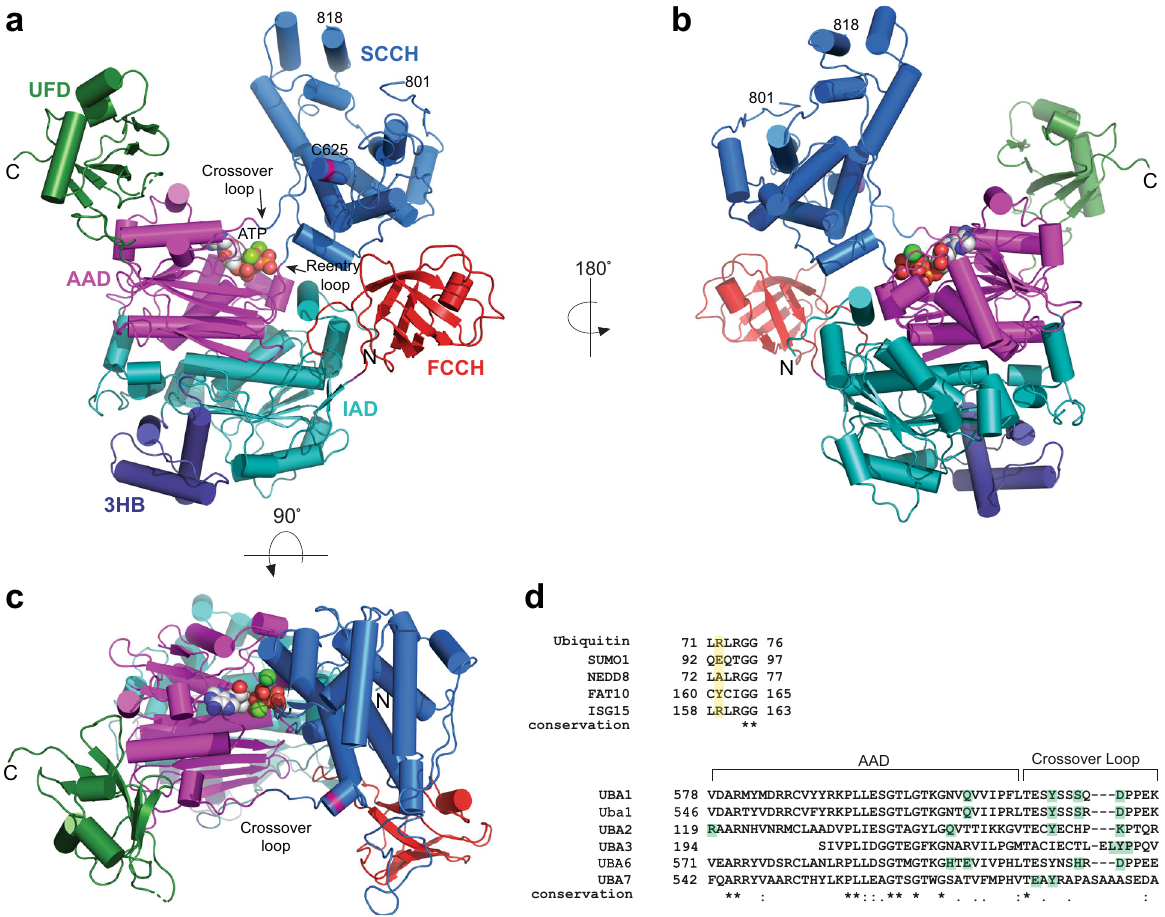
Fig. 1 | Overall structure of human UBA6. a Front, ( b ) back and ( c ) top views of the UBA6-ATP complex with the inactive adenylation domain (IAD) in cyan, the active adenylation domain (AAD) in magenta, the fi rst catalytic cysteine (FCCH) domain in red,the second catalytic cysteine (SCCH)domain in marine blue, the 3- helix-bundle(3HB)indarkblueandtheubiquitinfolddomain(UFD)indarkgreen. The crossover and reentry loops are indicated and the position of the active site